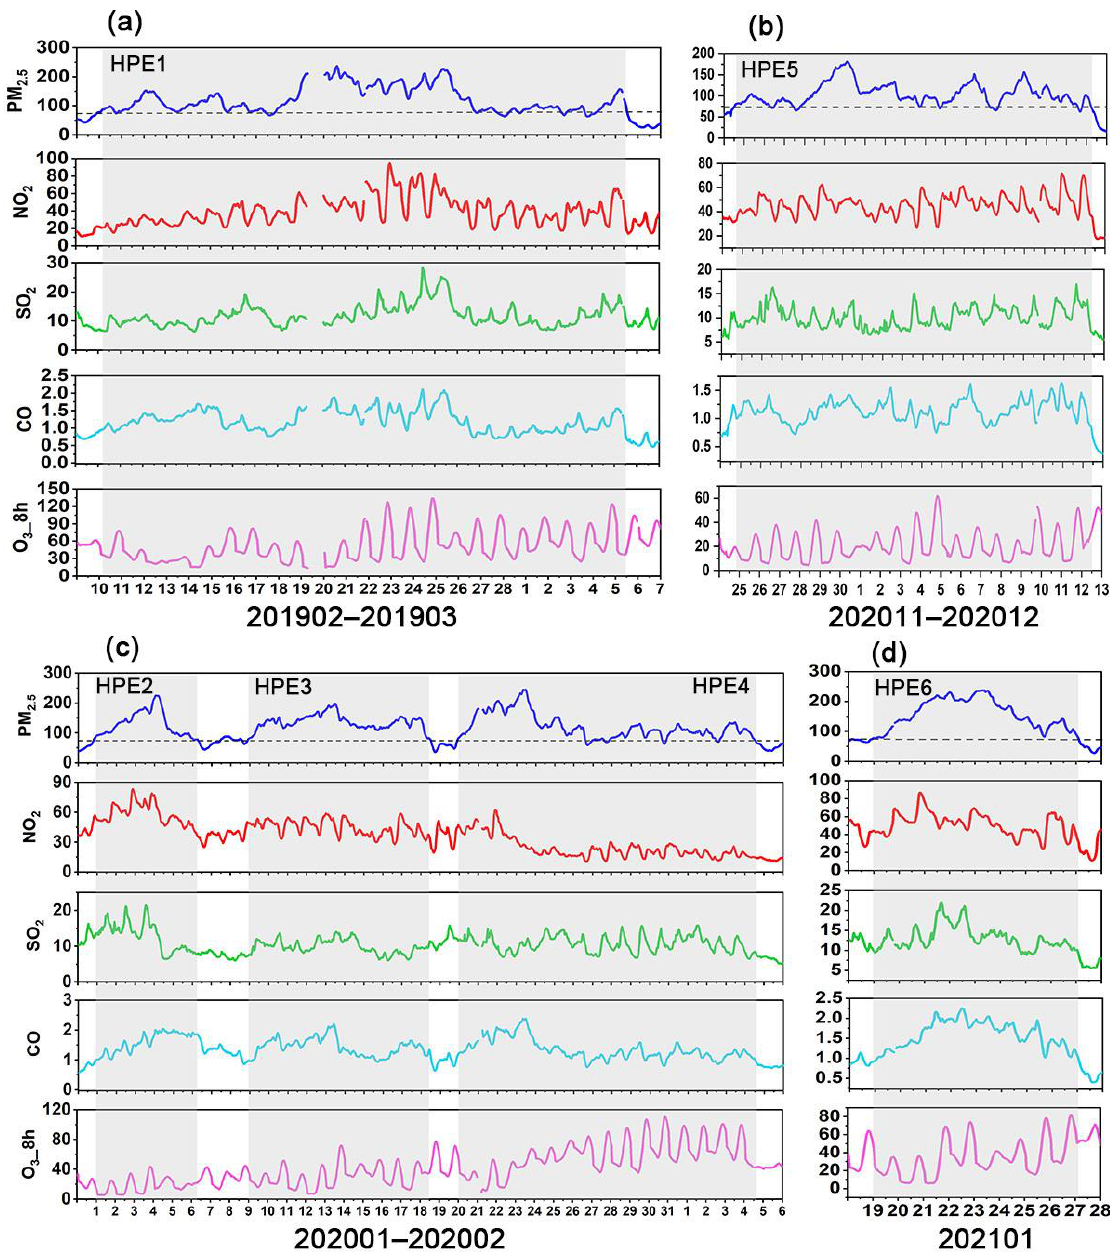
Figure 8. Time series of air pollutant concentrations during six heavy PM 2.5 pollution episodes (HPEs) in Henan. ( a ) HPE1, ( b ) HPE5, ( c ) HPE2, HPE3, and HPE4, and ( d ) HPE6. PM 2.5 , NO 2 , SO 2 , and O 3 _8h concentrations are in μg m −3 , and CO concentrations are in mg m −3 .